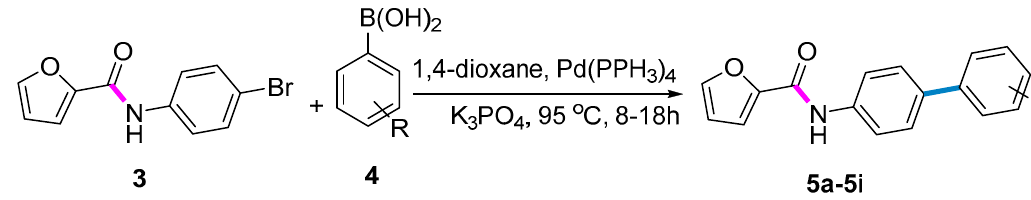
Figure 1. An overview of N -(4-aryl phenyl)furan-2-carboxamide ( 5a-i ) via Suzuki–Miyamura cross-coupling reactions. 2.2. Antibacterial Activity The MIC values of various antibiotics exhibited in Table 1 show that Gram-negative bacterial strains were resistant to the AWaRe (Access, Watch, and Reserve) WHO classes of antibiotics such as β -lactams, aminoglycosides, and quinolones, except for polymyxin. Further, MRSA displayed resistance to β -lactams, and quinolones and was sensitive to vancomycin and linezolid. Phenotypic detection revealed that all the GNR were car- bapenemase and MBL producers while Staphylococcus were MRSA. Therefore, in the pre- sent study, the molecules ( 3 ) and ( 5a-i ) were screened for antibacterial activity at different concentrations (10, 20, 30 40, and 50 mg/well) against XDR pathogens (CRAB, CRKP, CREC, and MRSA) by the agar well diffusion method. MIC and MBC were calculated by broth dilution methods. The results presented in Table 1 show that only compound ( 3 ) exhibited excellent activity against XDR pathogens. However, compound ( 5c ) displayed low activity as compared to compound ( 3 ), while the other molecules failed to present good activity. The zone of inhibition (mm) increased against all XDR pathogens with the increase in compound concentration. Compound ( 3 ) at 50 mg concentration showed the highest zone of inhibition (18 mm) against CRAB as compared to other pathogens while meropenem antibiotic was inhibited at a 4 mm zone of inhibition (Figure 2). The values of MBC and MIC of compound ( 3 ) were calculated against all tested XDR pathogens and the results showed that CRAB, CREC, and CRKP exhibited a MIC of 6.25 mg and MBC of 12.5 mg respectively, while MRSA exhibited a MIC of 12.5 mg and MBC of 25 mg, respectively (Table 2).